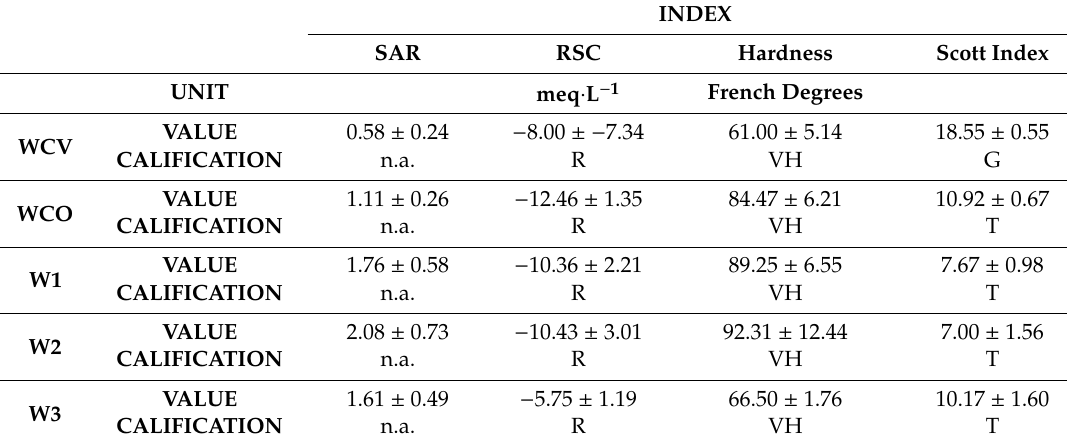
Table 3. Average values of the secondary